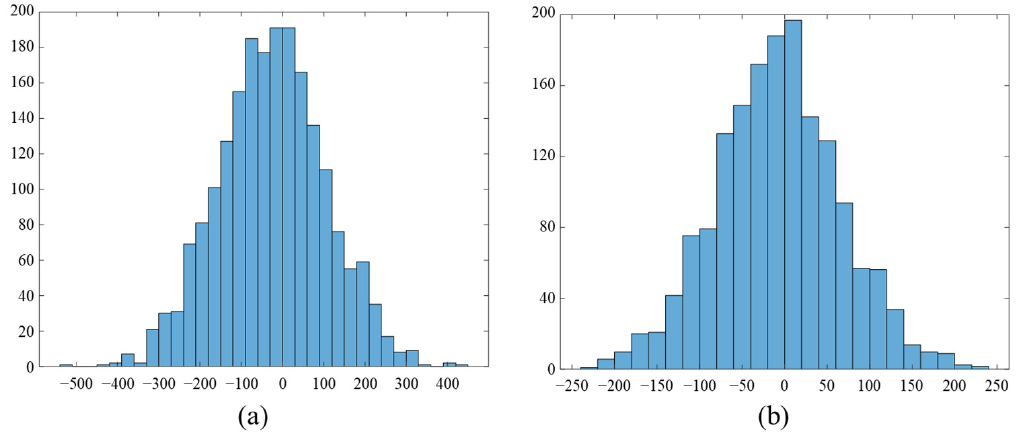
Figure 9. Illustration of the observed residual distributions of ( a ) low sub-band and ( b ) high sub-band signals.